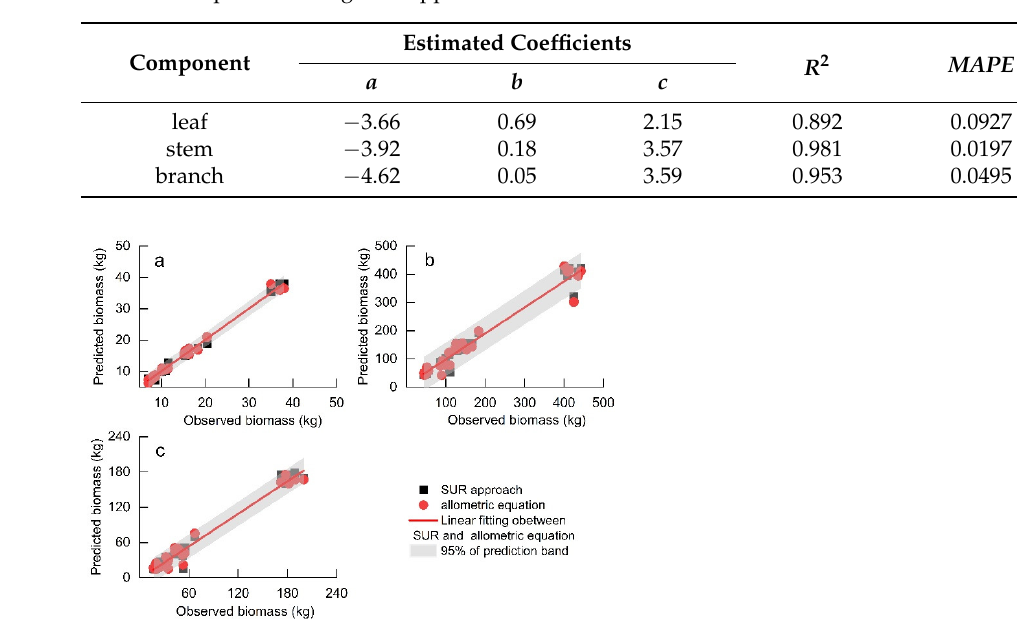
Figure 3. Comparison of the predicted leaf ( a ), stem ( b ) and branch ( c ) biomass against the corresponding observed biomass in T . Zhongshanshan plantations by SUR approach and allometric equation, respectively.